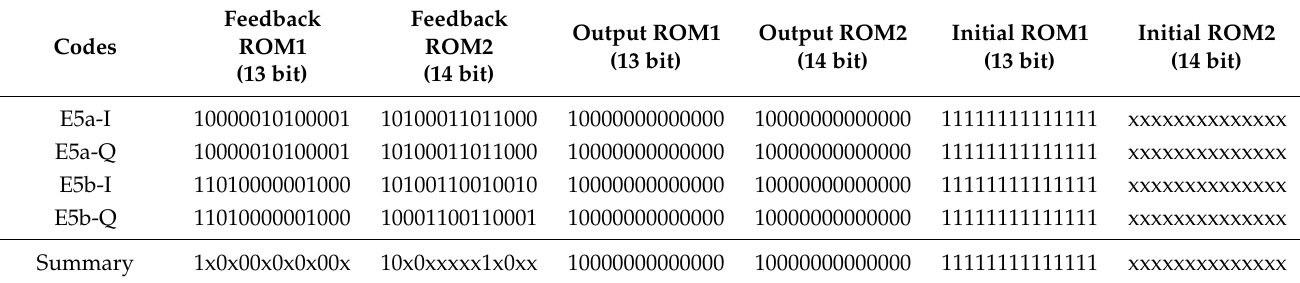
Table 5. The fixed parameters of code generators for Galileo